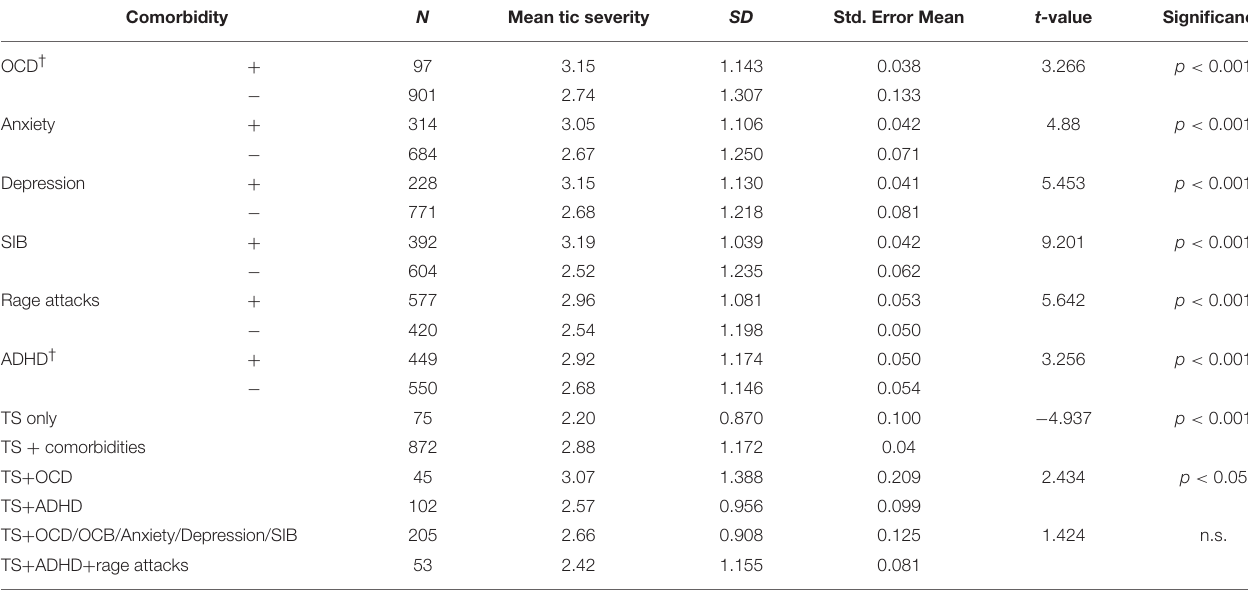
TABLE 4 | Tic severity depending on the presence ( ± ) of different comorbidities*. Comorbidity N Mean tic severity SD Std. Error Mean